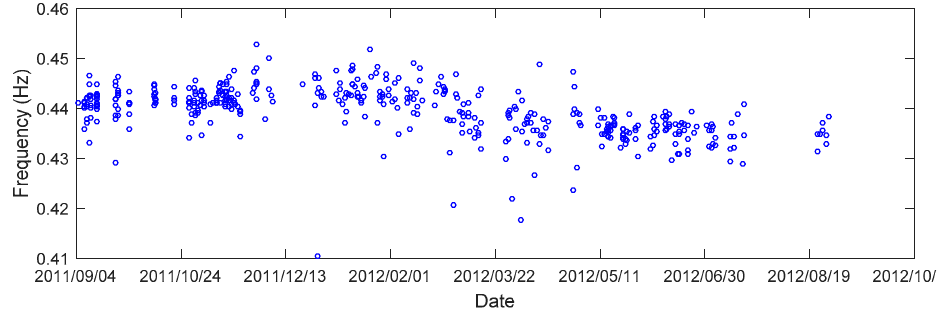
Figure 7. Identified modal frequencies of the 1st vertical mode during the monitoring period.